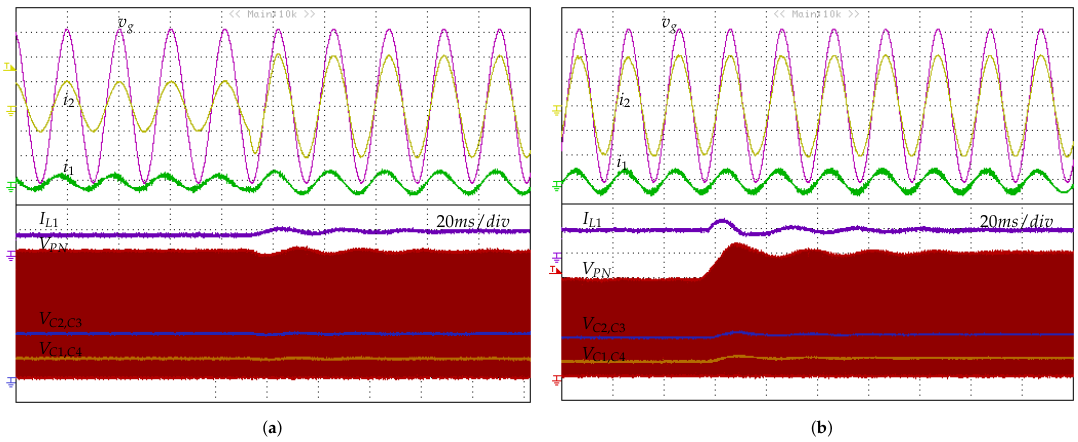
Figure 8. Experimental result of the dynamic response. ( a ) step on the grid current; ( b ) step on the capacitor voltage ( i 1 = 20 A/div, i 2 = 5 A/div, v g = 100 V/div, I L 1 = 10 A/div, V C 1